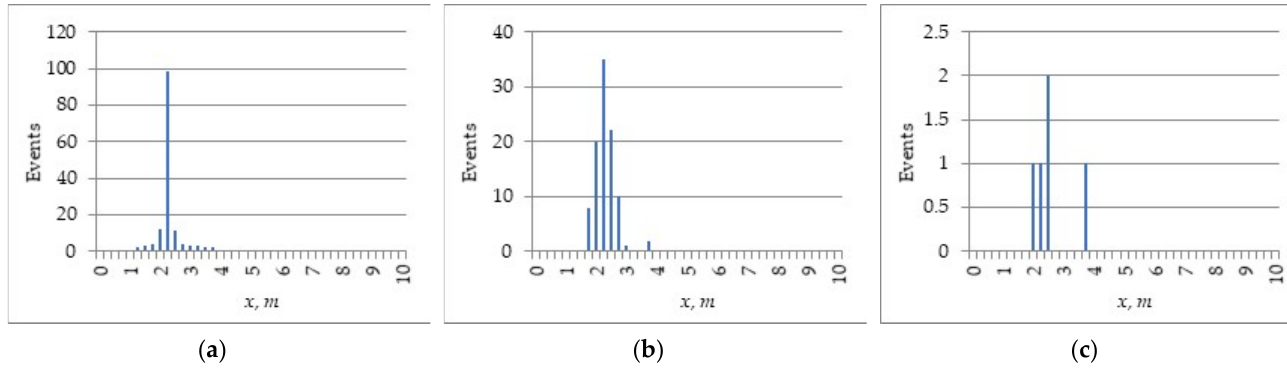
Figure 11. Result of AE source location with different amplitude thresholds: 30 dB ( a ), 35 dB ( b ) and 40 dB ( c ).